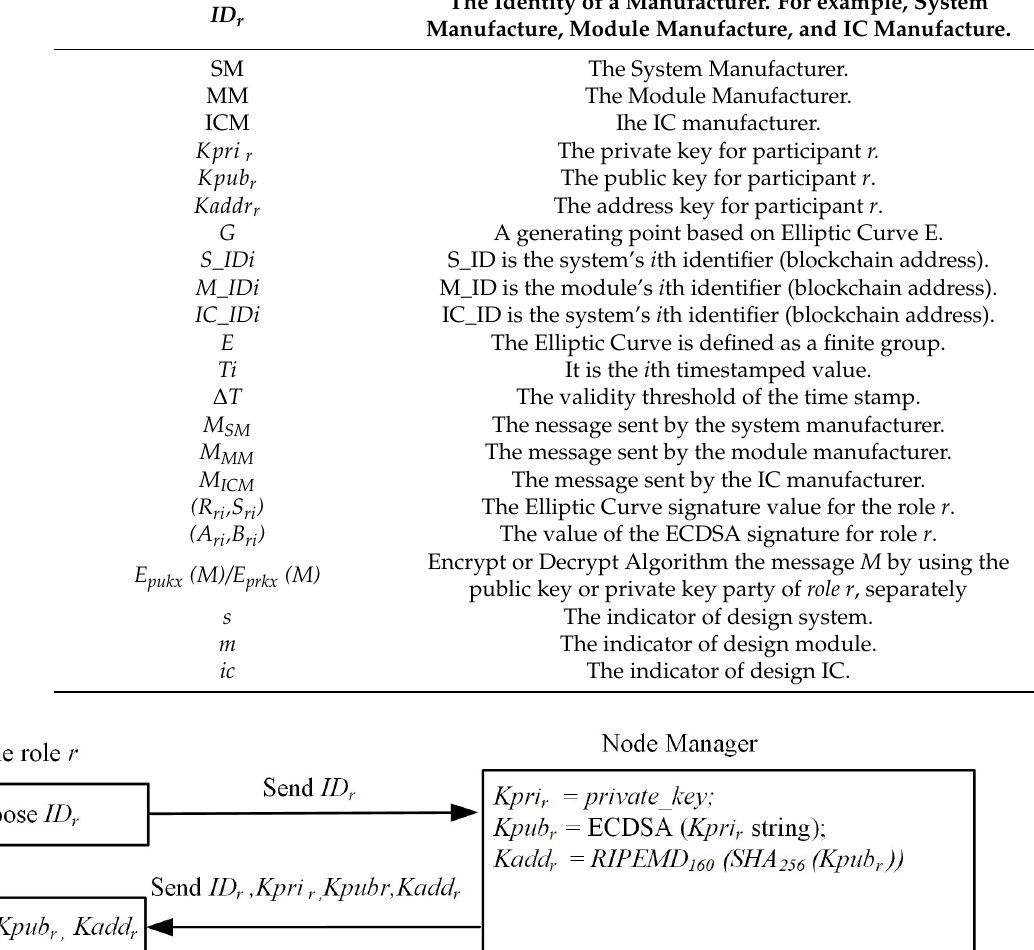
Table 3. Notations.